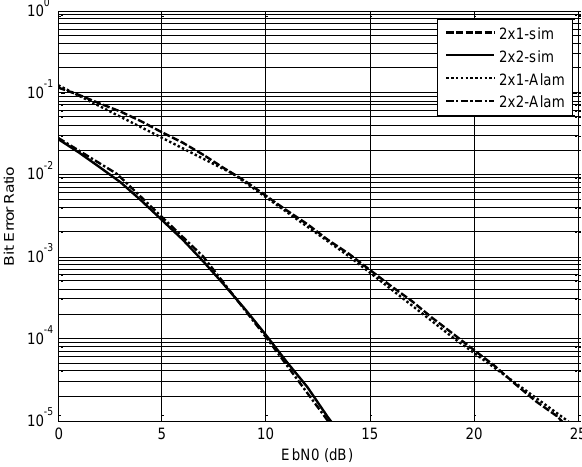
Figure 6: Results of 2×1 and 2×2 MIMO using STBC for the BPSK